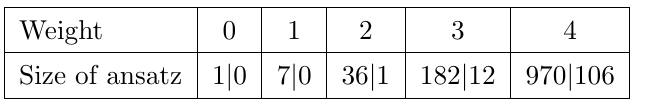
Table 3 . Number of even odd integrable symbols with seven allowed first entries and satisfying the | second entry